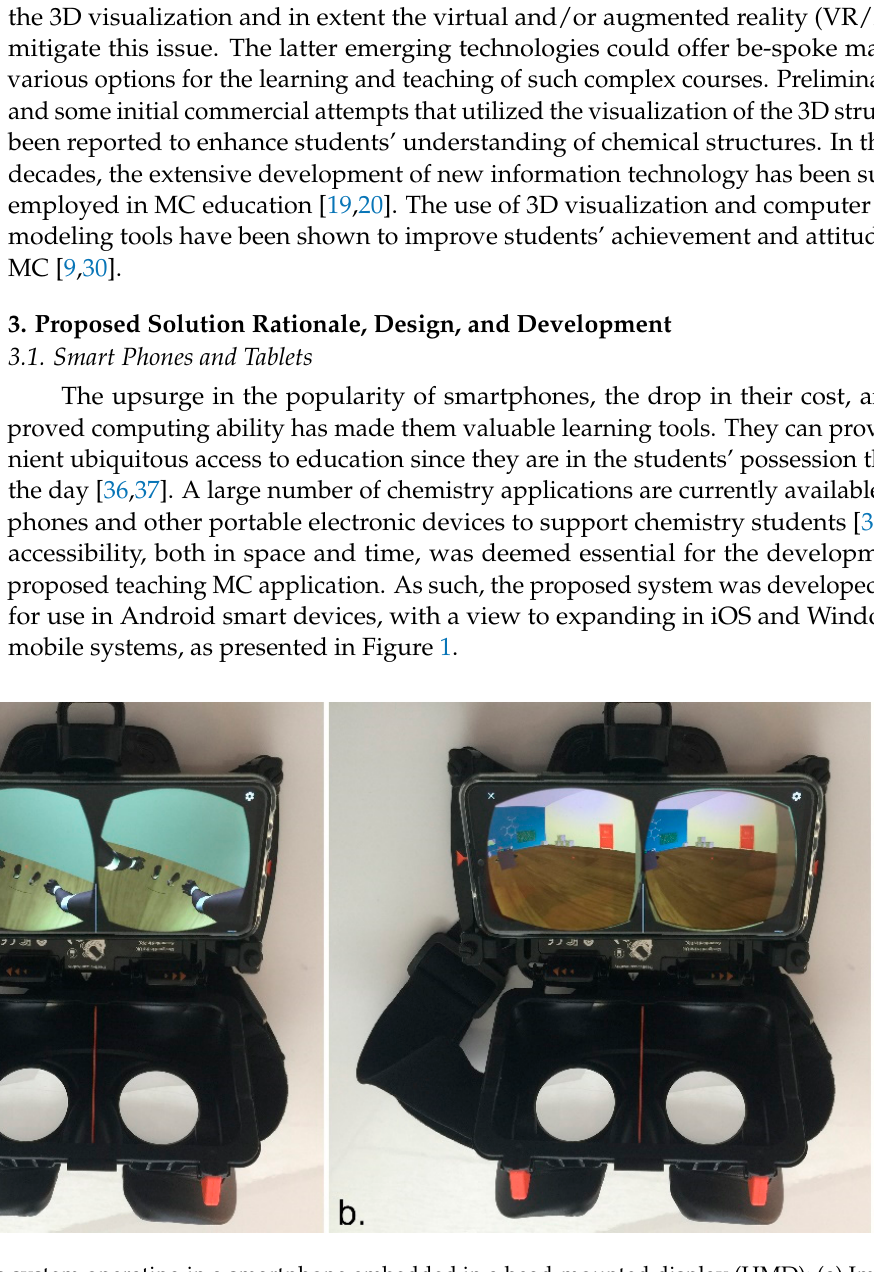
Figure 1. Screenshots of the system operating in a smartphone embedded in a head-mounted display (HMD): ( a ) Image of the user’s digital body representation in the virtual reality (VR) environment. ( b ) Image of the virtual classroom with the hovering molecular structures under investigation.